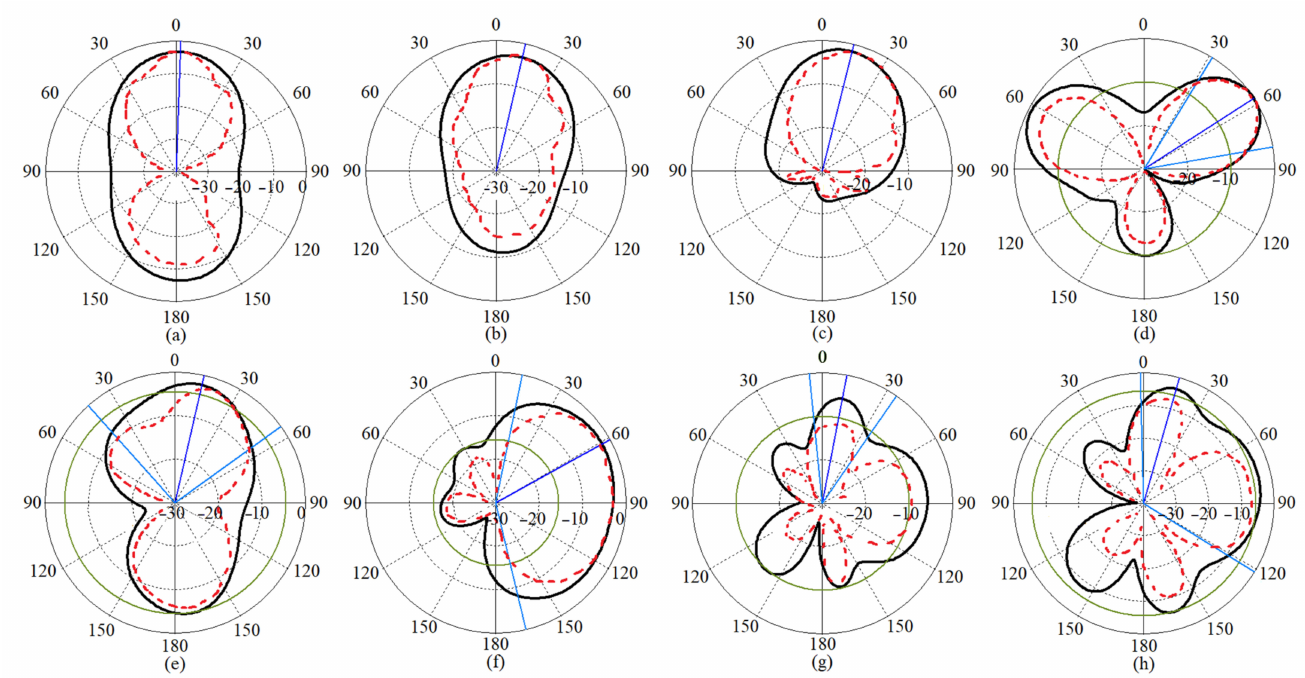
Figure 17. Radiation patterns of MTM-based MAVA for port 2 at: ( a ) 3.8 GHz, ( b ) 5.4 GHz, ( c ) 8 GHz, ( d ) 12 GHz, ( e ) 18 GHz, ( f ) 22 GHz, ( g ) 25 GHz, and ( h ) 28 GHz in free space (black line: simulated co-polarization, red dashed line: measured co-polarization, on the xz